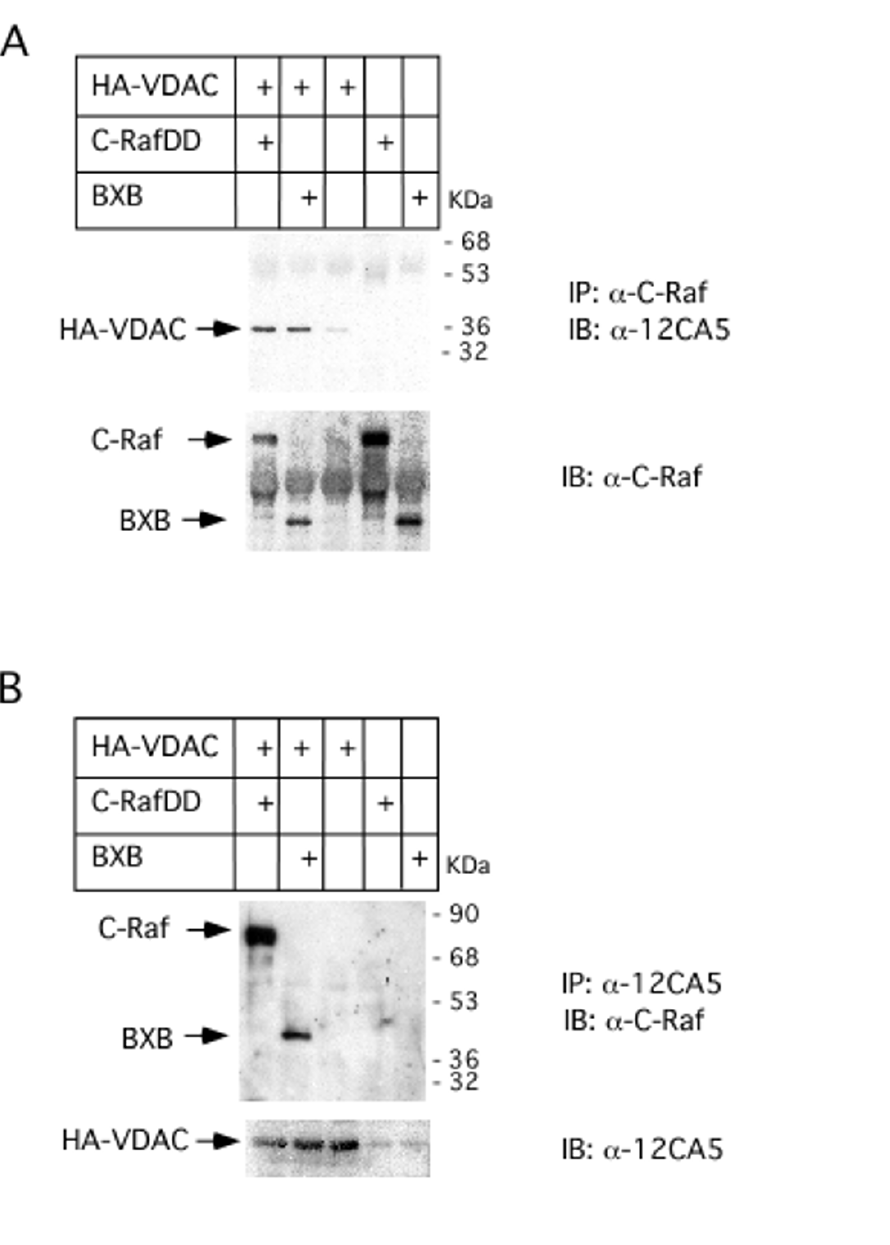
Figure 4 C-Raf interacts with VDAC. C-Raf and HA-VDAC proteins were transiently coexpressed in 293 cells and immunoprecipitated with anti-C-Raf (A) or anti-HA antibodies (B) before SDS-PAGE analysis. Immunoblot were probed with anti-C-Raf or anti-HA